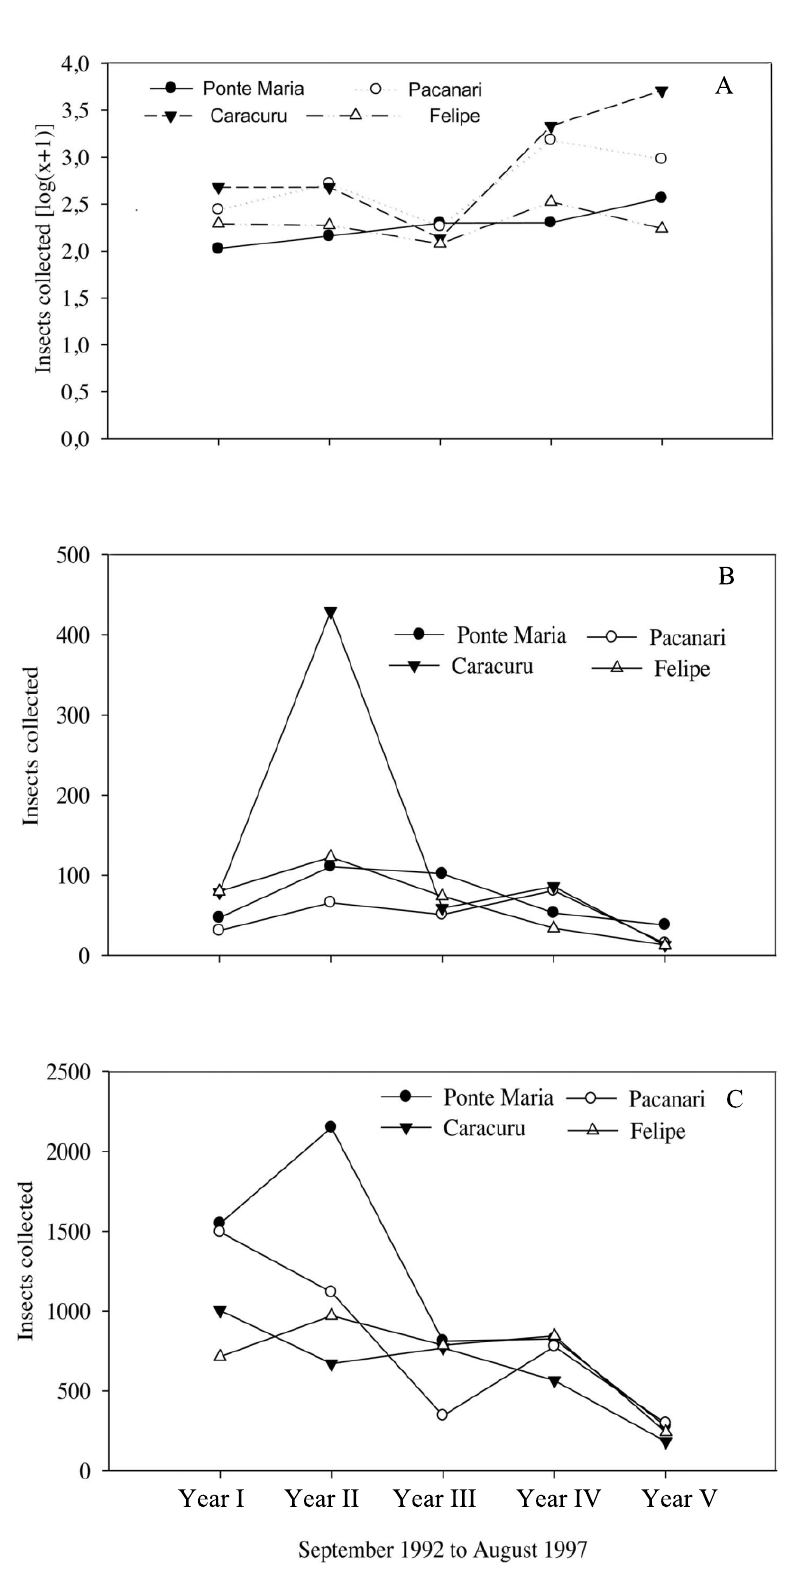
Figure 1. Number of individuals of Lepidoptera primary pests ( A ), secondary pests ( B ), and species with no defined importance to eucalypts ( C ) collected in Eucalyptus urophylla plantations in Ponte Maria, Pacanari, Caracuru, Pará State, and Felipe, Amapá State,